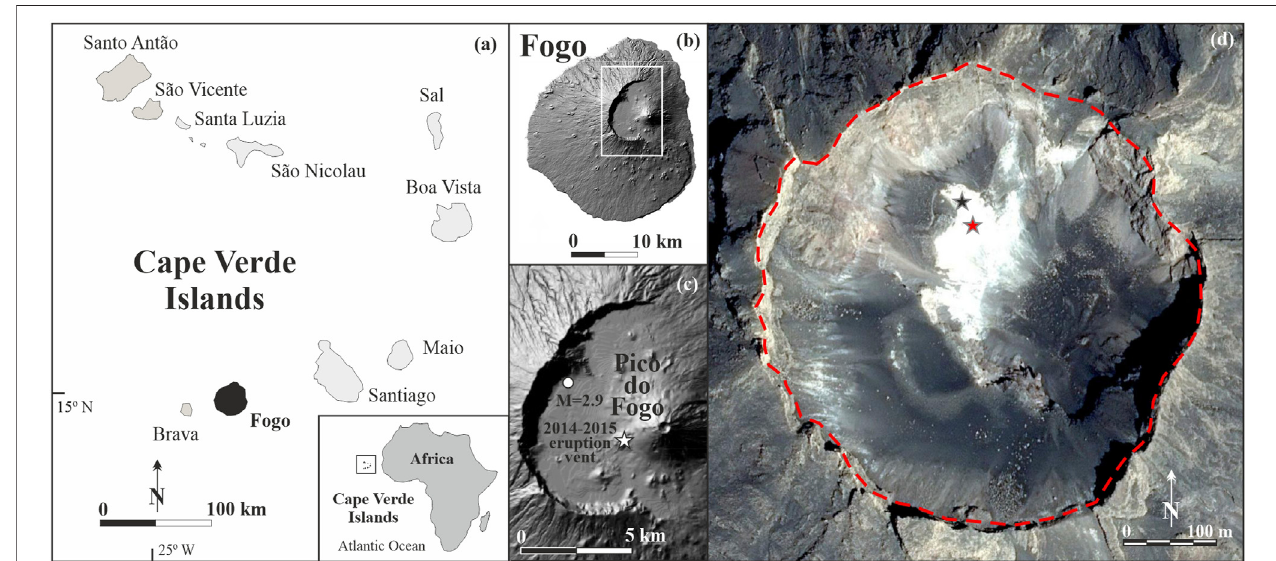
FIGURE1|(A) GeographicallocationofFogo IslandinCapeVerde. (B) Shaded relief mapofFogoIslandwiththelocationofChadas Caldeiras (whitesquare). (C) ShadedreliefmapofChadasCaldeirasshowingPicodoFogovolcano.Thewhitestarindicatesthelocationofthemainventofthe2014 – 2015eruption.Thewhitecircle indicates thelocationofthe earthquake (M (cid:2) 2.9) occurred on April 12,2012(Pérez et al.,2015). (D) Aerial viewofPico do Fogo craterwith thelocationofF1 (black star) and F2 (red star) fumaroles.